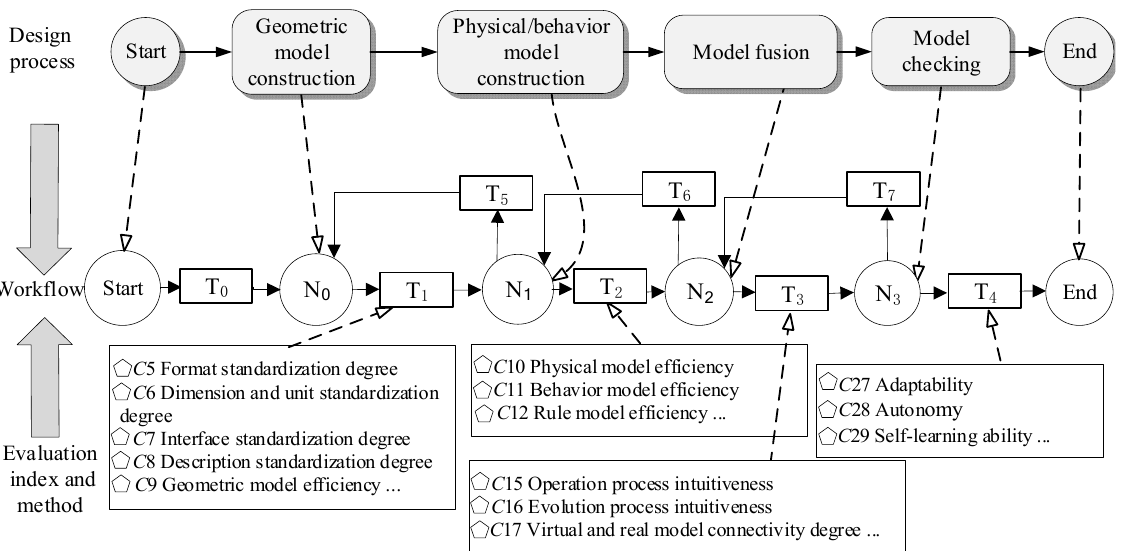
Figure 8. Design process.